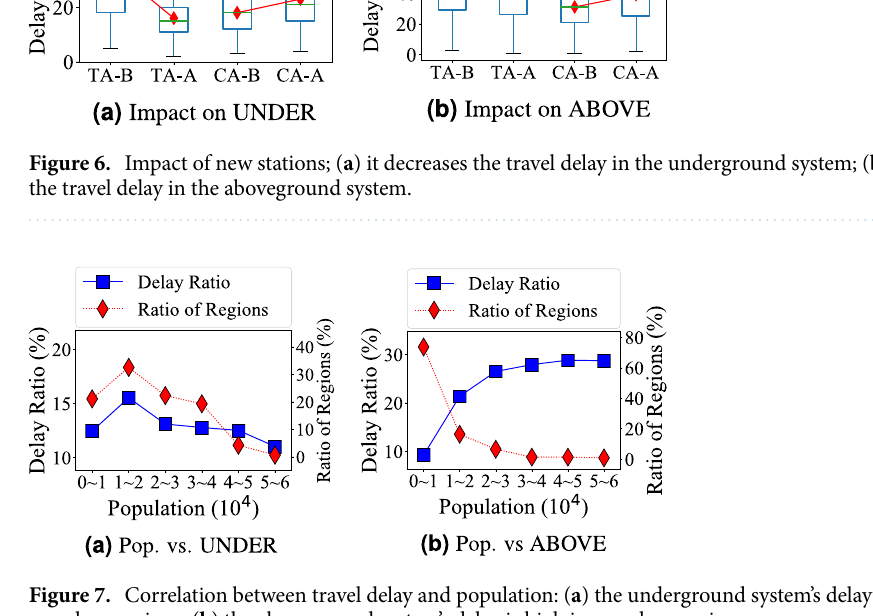
Figure 7. Correlation between travel delay and population: ( a ) the underground system’s delay is low in populous regions; ( b ) the aboveground system’s delay is high in populous